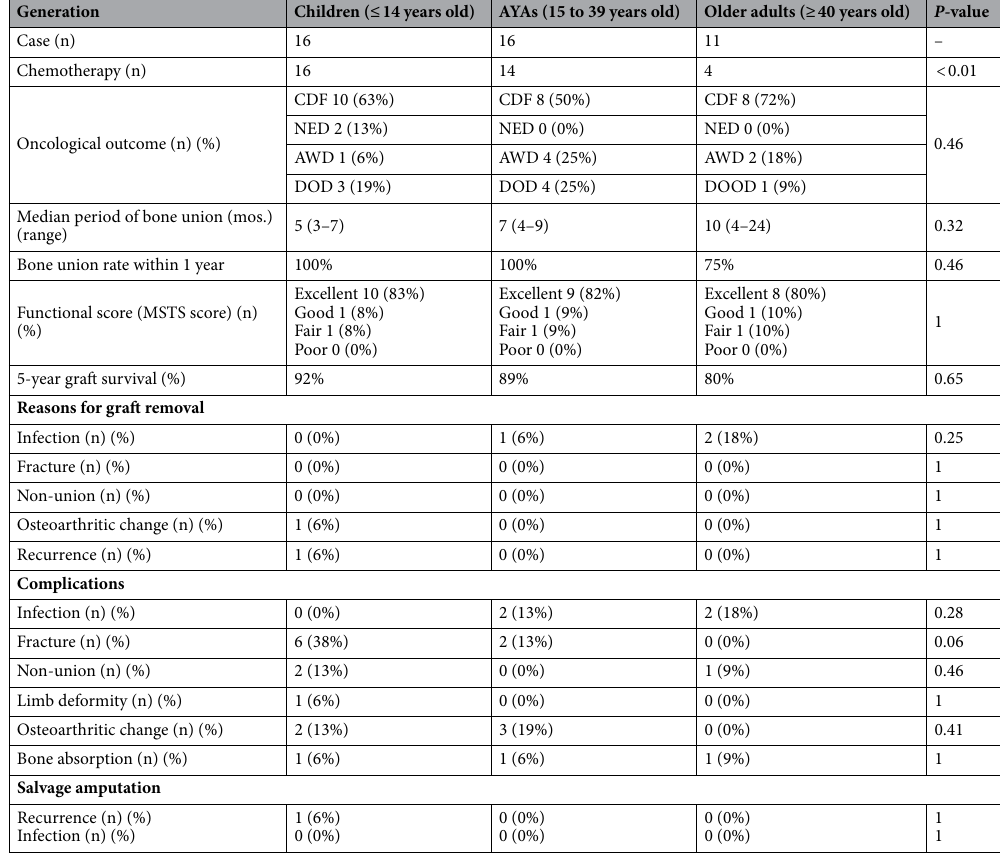
AWD alive with disease, DOD dead of disease, DOOD dead of other diseases, MSTS Musculoskeletal Tumor